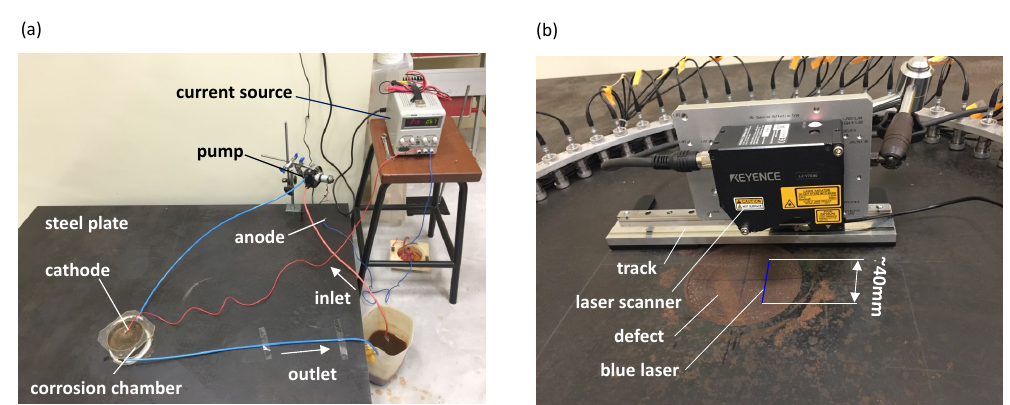
Figure 5. ( a ) The experimental setup of the forced corrosion and ( b ) a laser profile scan of the corrosion defect in a 10 mm steel